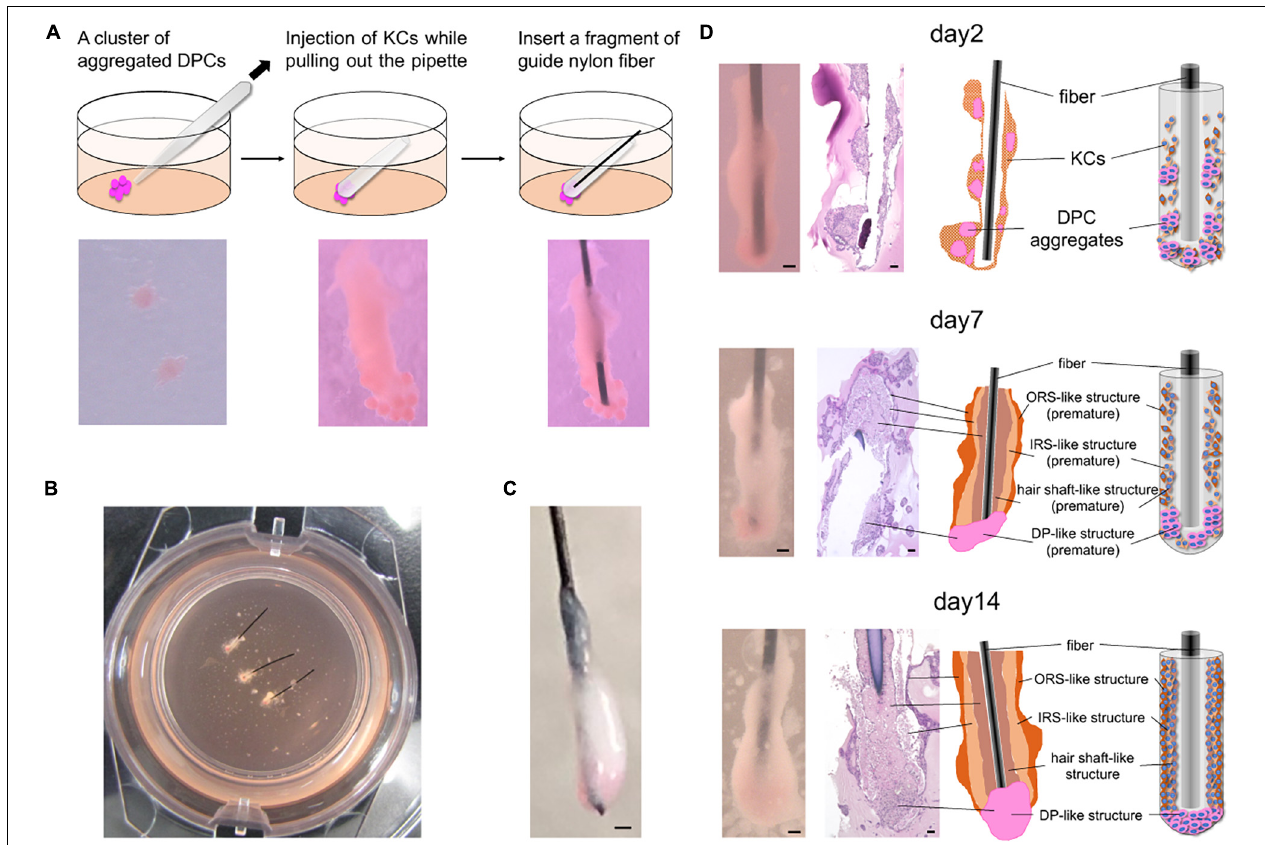
FIGURE 1 | In vitro 3D regeneration of KC-DP constructs and time course changes in their intratissue architecture to mimic representative HF structural features during 2-week culture. (A) The schema of the reconstruction steps. DP (or iDPSC) aggregates were placed in Matrigel to form clusters. Condensed cylindrical KC structure was placed in close contact with DP aggregates. A nylon fiber was inserted as a structural supporter and guide for histological sectioning. (B) KC-DP constructs in Matrigel after 1-week culture. (C) KC-DP constructs harvested after 2-week culture. The approximated size was analogous to that of human HF. (D) Time course change in the intratissue architecture of KC-DP constructs at 2 days, 1 week, and 2 weeks. The constructs gradually reorganize their structure and formed densely gathered DP aggregates and multiple KC layers (ORS-, IRS-, and hair shaft-like) sketchily mimicking human HFs, especially the bulb and suprabulbar portion. DP, dermal papilla; DPC, dermal papilla cells; KC, keratinocyte; IRS, the inner root sheath; ORS, the outer root sheath. Scale bar: 200 µ m.